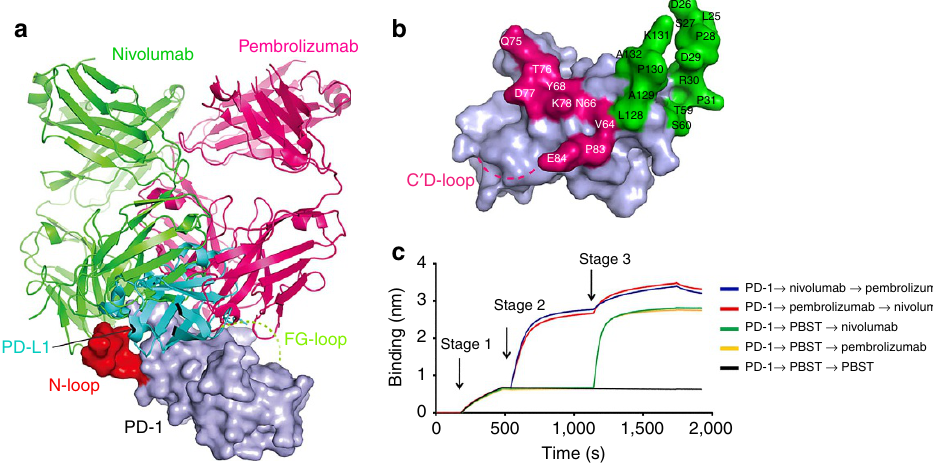
Figure 6 | Distinct blockade binding mode compared with pembrolizumab. ( a ) Superposition of PD-1-nivolumab-Fab, PD-1-pembrolizumab-Fab with the PD-1-PD-L1 complex structure. Nivolumab-Fab and pembrolizumab-Fab are coloured in green and magenta, respectively, and PD-L1 is coloured in cyan. PD- 1 is shown as surface representation. The N-loop targeted by nivolumab is highlighted in red, and the unavailable pembrolizumab targeted C’D loop is indicated as dashed lines in lemon. Nivolumab and pembrolizumab bind to PD-1 in two different orientations with some clash regions. ( b ) Binding surface of PD-1 by nivolumab or pembrolizumab. The binding residues in contact with nivolumab are coloured in green, whereas residues in contact with pembrolizumab are coloured in magenta. ( c ) The Octet competition binding assay of nivolumab or pembrolizumab binding to PD-1. Ni-NTA sensors loaded with PD-1 at stage 1 were first saturated with the indicated MAbs (10 m gml (cid:2) 1 ) or PBST buffer at stage 2. The capacity of additional binding was monitored by measuring further shifts after injection of the other antibody (10 m gml (cid:2) 1 ) in the presence of the first antibody at stage 3. The result shows that nivolumab binding to PD-1 have partial competition with pembrolizumab.